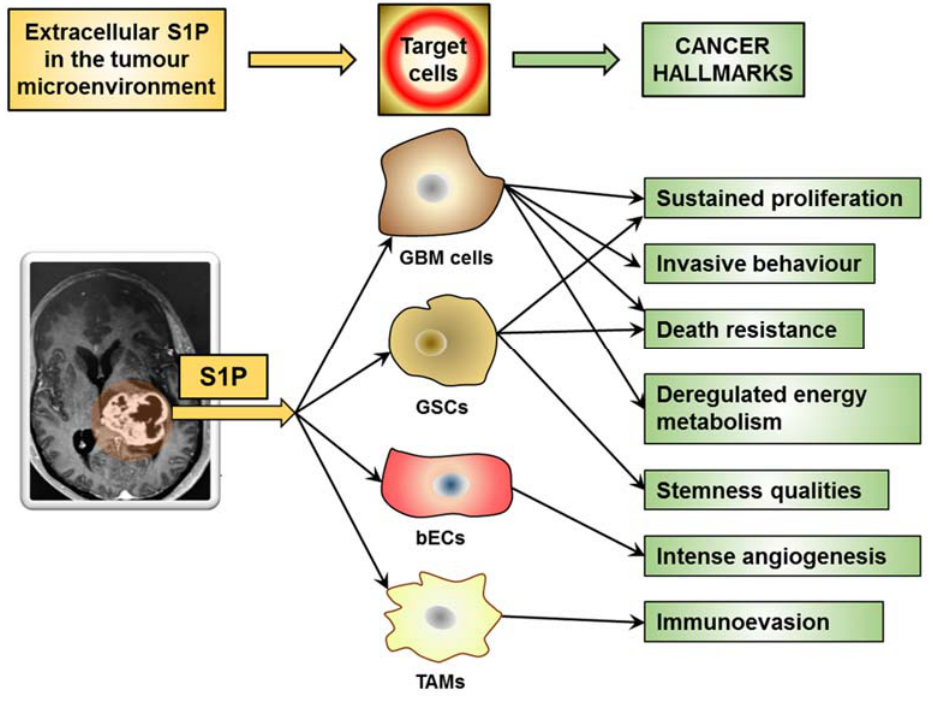
Figure 3. S1P in the GBM microenvironment promotes aggressive cancer hallmarks.